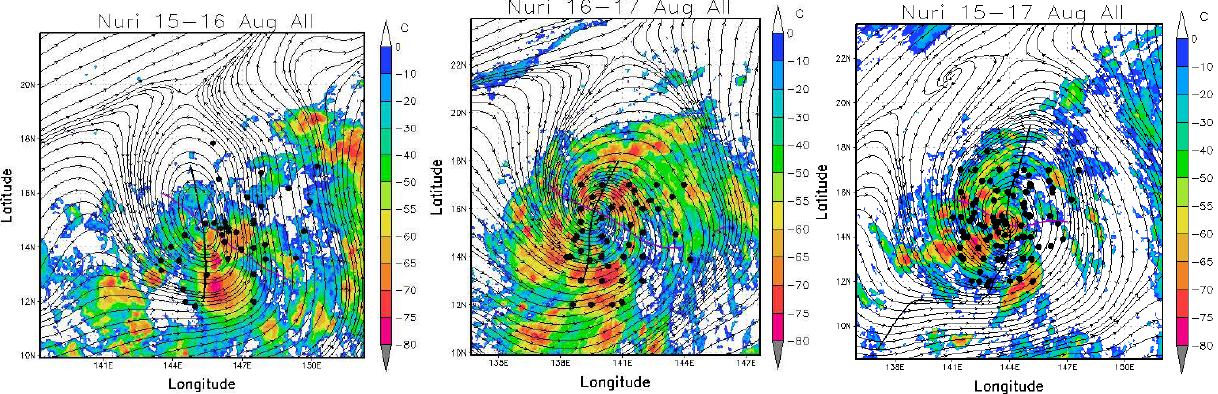
Fig. 2. Dropsonde locations for Nuri1 and Nuri2 as viewed in the co-moving frame of reference with the parent wave-like disturbance (moving approximately 7 m s − 1 westward). The usable drop points and co-moving streamlines at the 925 hPa level from the GFS FNL analysis are superimposed on the satellite brightness temperature. The color bar for the brightness temperature is indicated. The orange and red colors indicate the approximate cloud-top temperatures of areas of active deep convection and their associated anvil clouds. Shown are (a) dropsonde locations for Nuri1 together with 925 hPa co-moving streamlines and brightness temperature at 00Z 16 August; (b) dropsonde locations for Nuri2 together with 925 hPa co-moving streamlines and brightness temperature at 00Z 17 August; (c) drop locations for both Nuri1 and Nuri2 translated to the 12Z 16 August brightness temperature image and co-moving streamline field, the time nearest the genesis time as declared by Joint Typhoon Warning Center forecasters. The purple curve denotes the local critical latitude where the parent wave’s zonal phase speed coincides with the mean zonal flow at the 925 hPa level. The dark black curve denotes the trough axis of the wave disturbance at this same level. The intersection between these two curves denotes the sweet spot of the pouch region (see Montgomery et al. (2010) for further details).